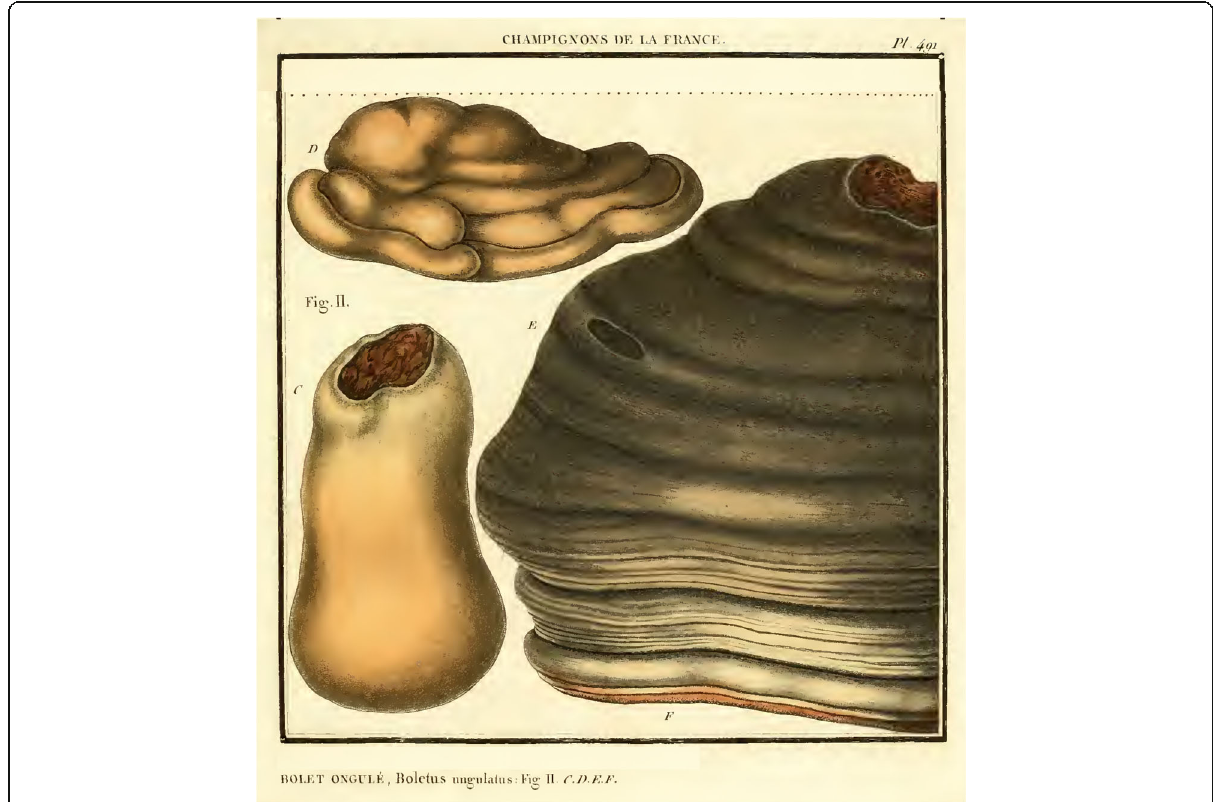
Fig. 10 Fomes inzengae : basidiome slice of Polyporus inzengae no. 636 (lectotype) with hand-written label and printed protologue (cut out from Erb. critt. Ital., ser. 1 ). The lectotype is currently secondarily intermixed with another series “ Mycotheca Universalis ” (SIENA). Bar = 1